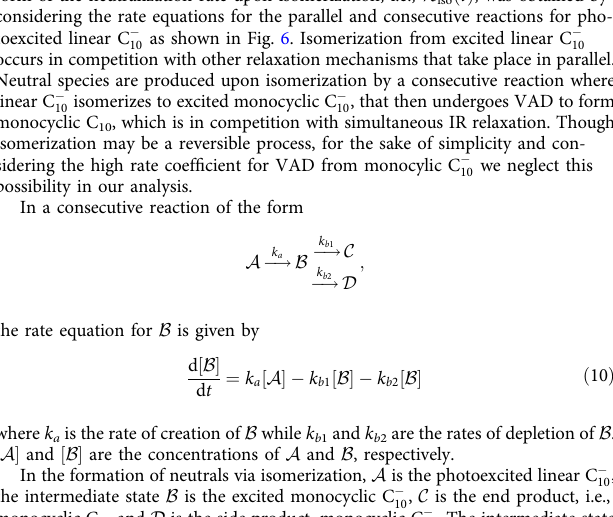
and vibrational 10